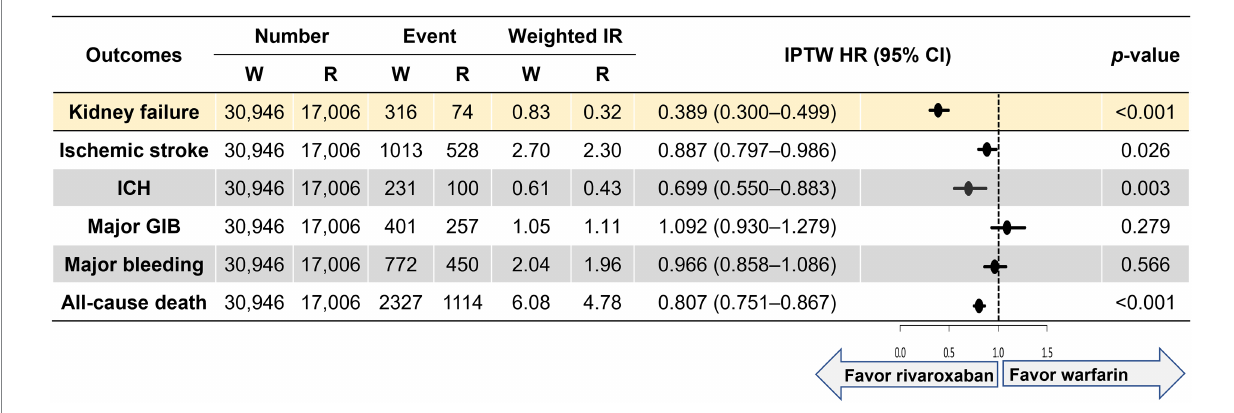
FIGURE 2 Weighted event numbers, incidence rates, and hazard ratios for the primary and secondary outcomes between warfarin and rivaroxaban groups. Incidence rate, per 100 person-years. CI, confidence interval; GIB, gastrointestinal bleeding; ICH, intracranial hemorrhage; IPTW, inverse probability of treatment weighting; IR, incidence rate; R, rivaroxaban; W,